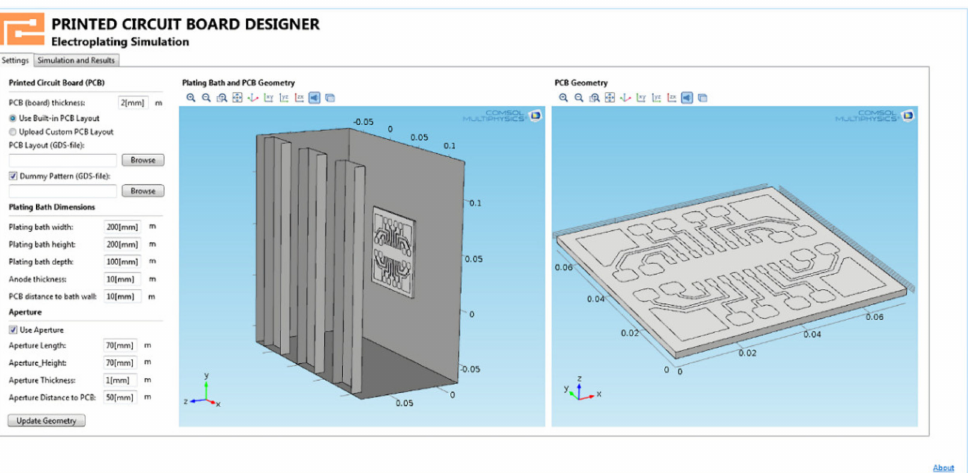
Figure 3. Example of an application that implements the visualization of the predicted thickness of the copper coating of the designed